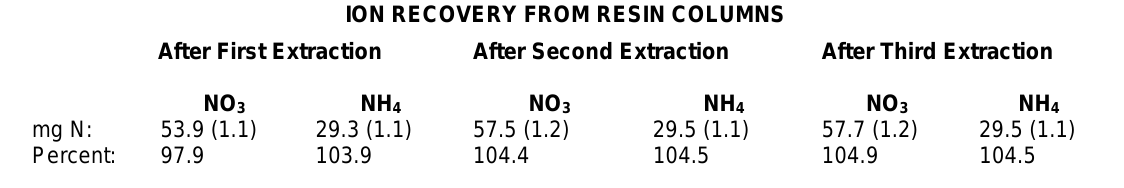
Laboratory Test of Ion Extraction Procedure from Ion Exchange Resin Columns. Resin Columns were Preloaded with a Known Amount of Nitrate and Ammonium in a